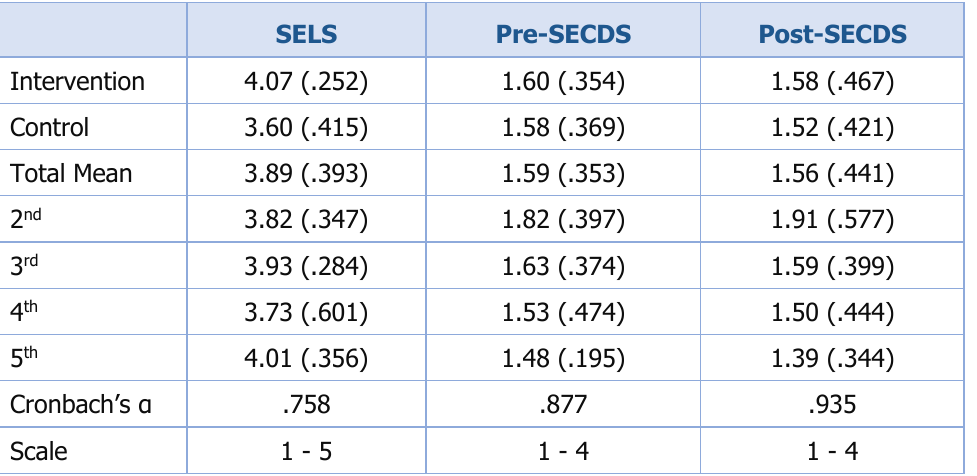
Table 2. Means and Standard Deviations for All Latent Factors by Site and